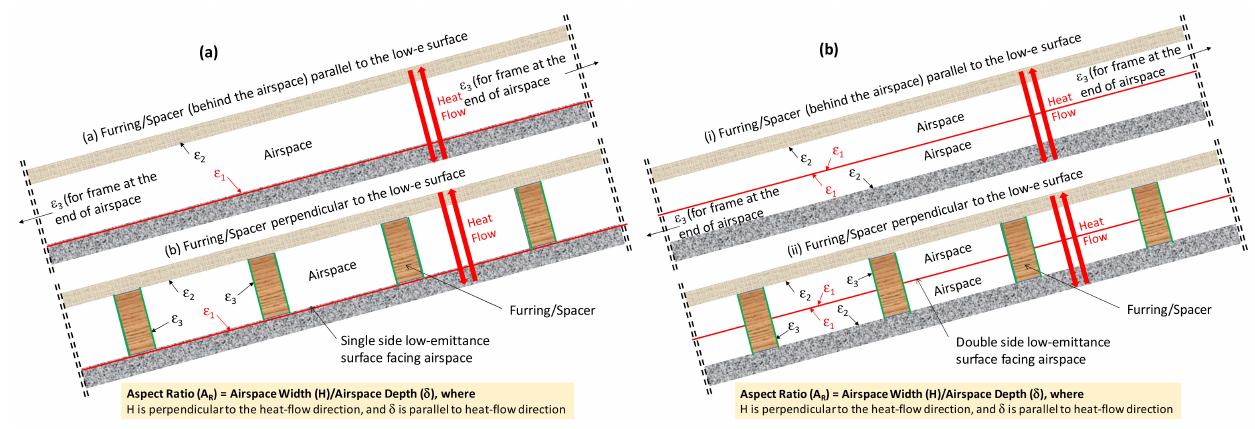
Figure 1. Schematic of enclosed airspace systems for building applications (( a ) single-enclosed airspace system and ( b ) double-enclosed airspace